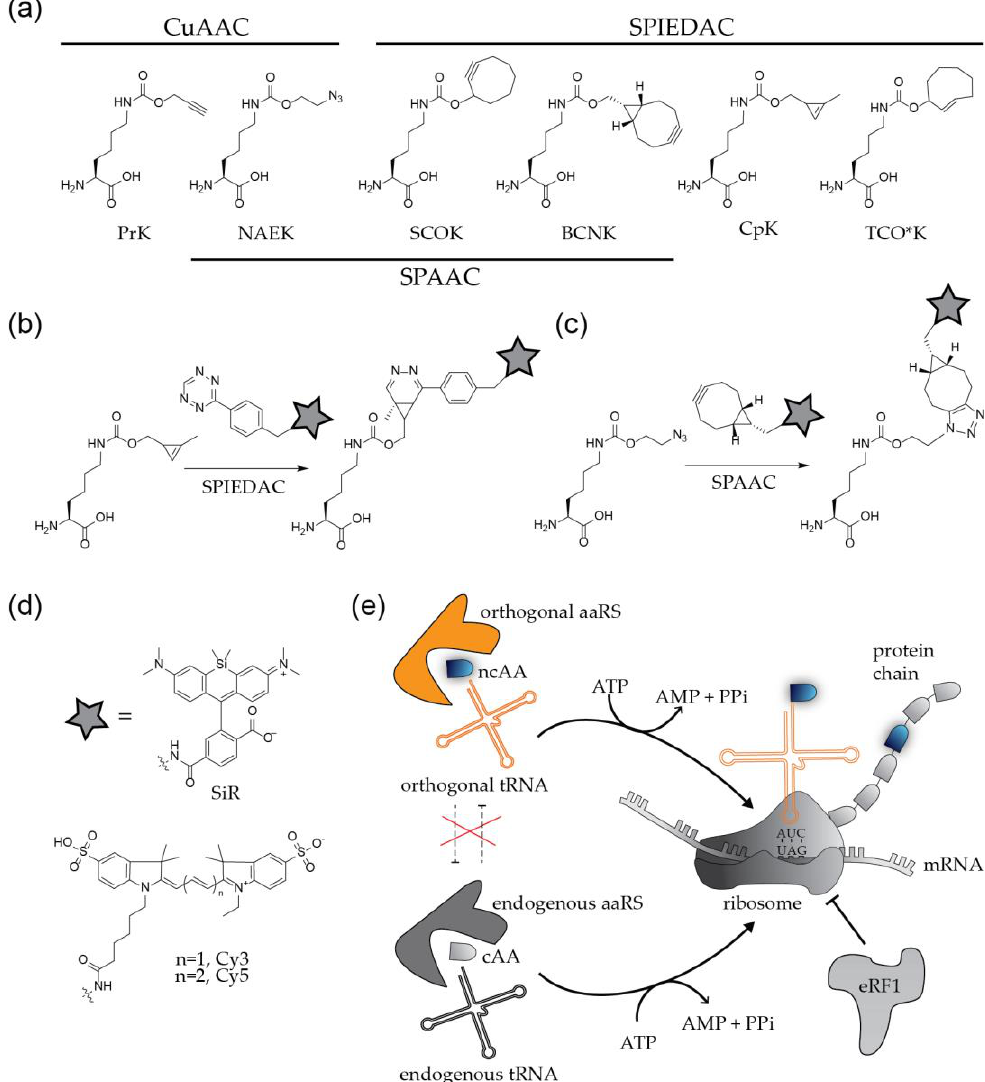
Figure 3. Labeling of proteins by genetic code expansion and click chemistry. ( a ) Structures of non-canonical amino acids frequently used for protein modification. ( b , c ) Coupling of functionalized fluorophores to bioorthogonal amino acids via strain promoted cycloadditions. ( d ) Organic fluorophores frequently applied in virological studies. ( e ) Principle of site-specific incorporation of ncAAs by amber suppression.